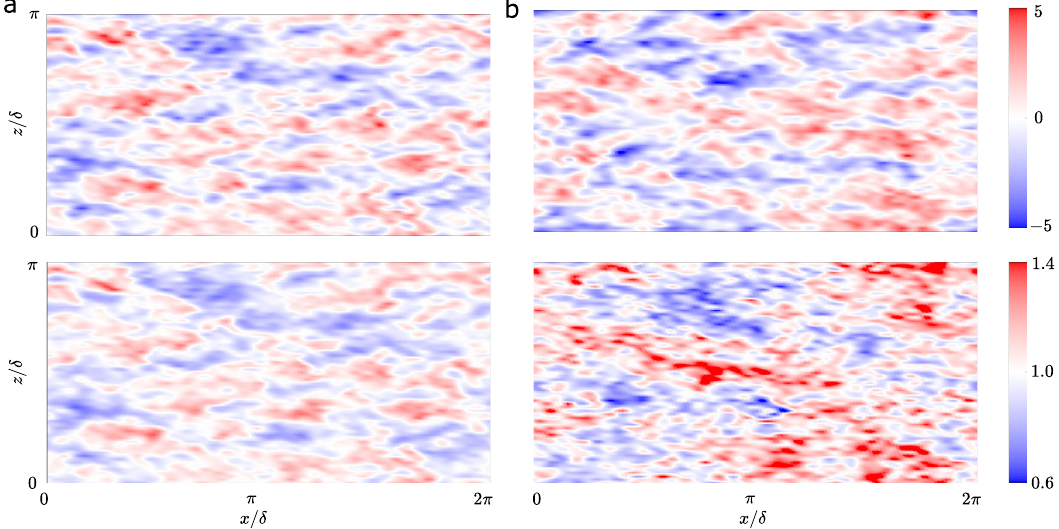
Fig. 6 Comparison of the instantaneous off-wall streamwise velocity and wall-shear stress. Instantaneous snapshots of x – z plane of streamwise velocity fl uctuation u 0 (cid:2) at h m (top) and τ m = τ w (bottom) for ( a ) EQWM and ( b ) w